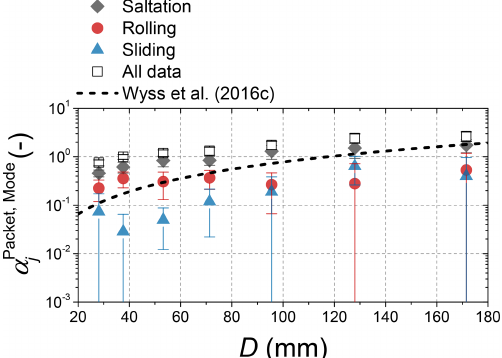
Figure 11. The number of packets divided by the number of trans- ported particles for each transport mode ( α Packet , Mode ) as a func- j tion of bedload particle size D in the range from 28.1 to 171.5mm. “All data” represents the sum of the packets generated by saltat- ing, rolling, and sliding particles. The results from the flume exper- iments are also compared to the data from the Erlenbach field mea- surements analyzed by Wyss et al. (2016a) for a mean flow velocity of 5ms − 1